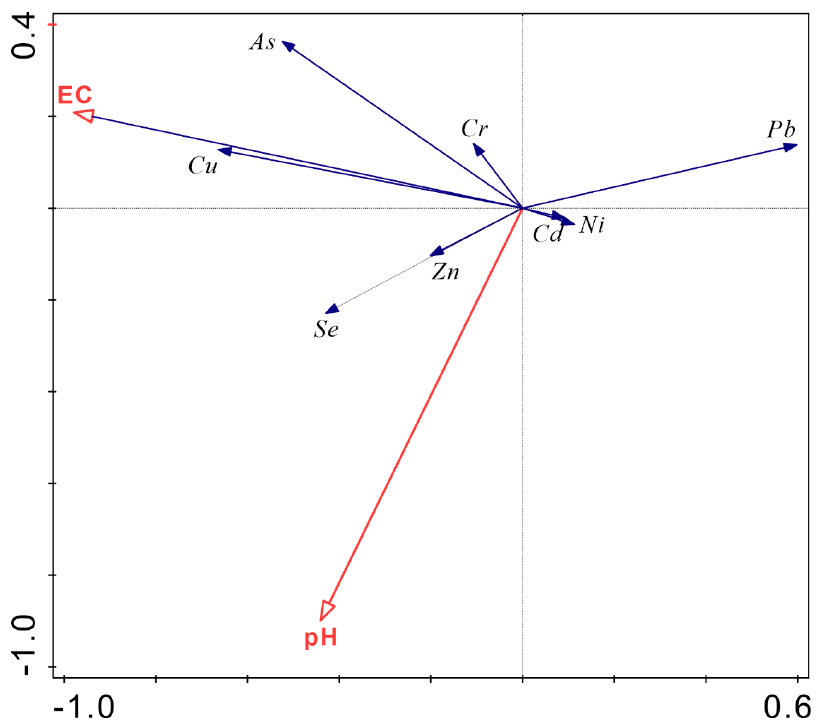
Figure 11. Redundancy analyses for the correlation between the pH, EC and the potential toxic elements in the waters of Bosten Lake.